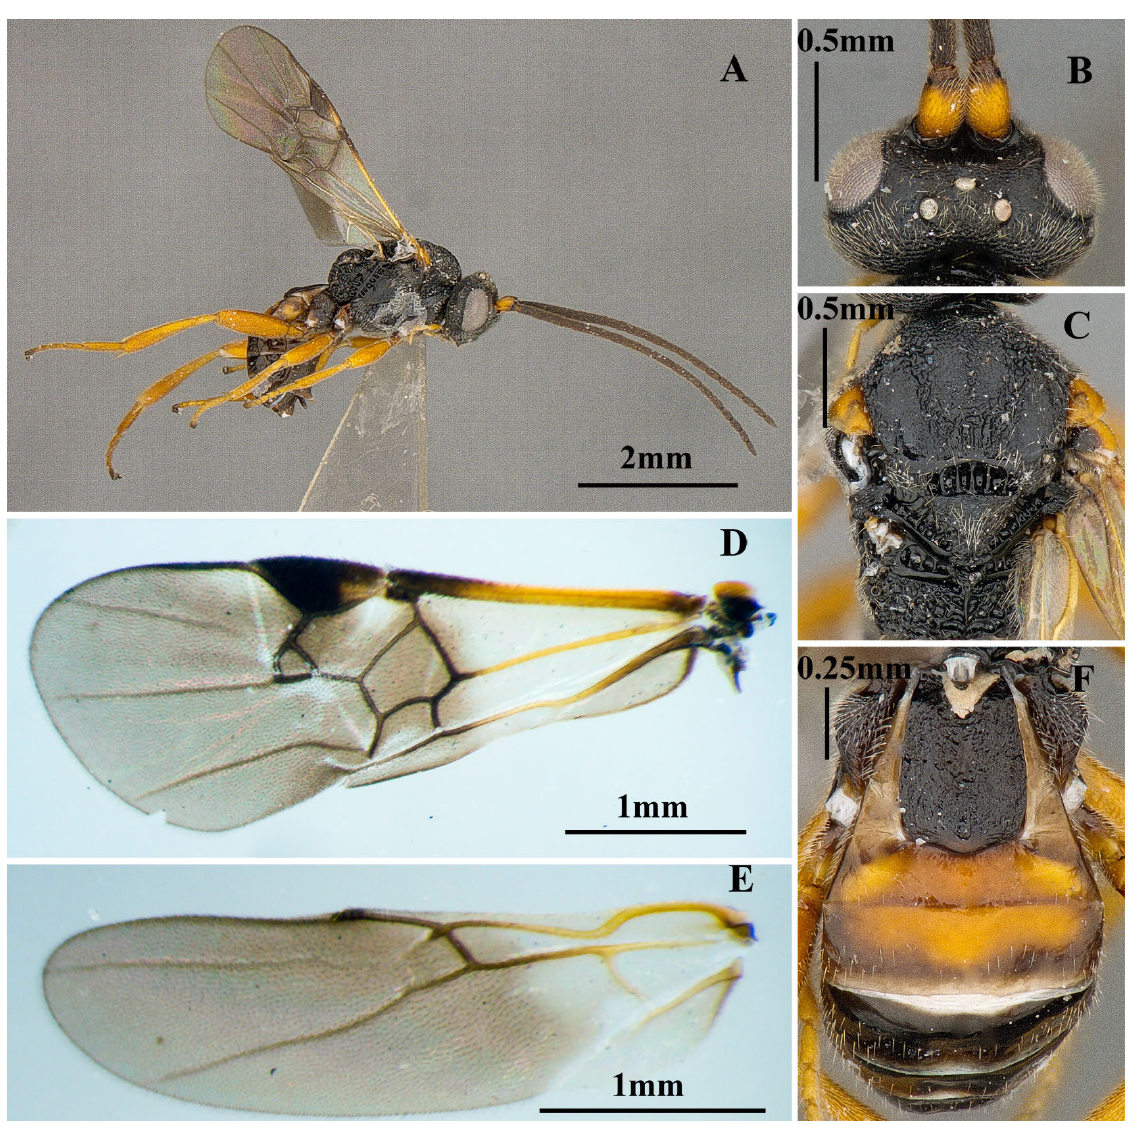
Fig. 6. Microplitis kaszabi Papp, 1980, ♀, TMUC-HBMMP0047. A . Habitus, lateral view. B . Head, dorsal view. C . Mesosoma, dorsal view. D . Fore wing. E . Hind wing. F . Metasoma, dorsal